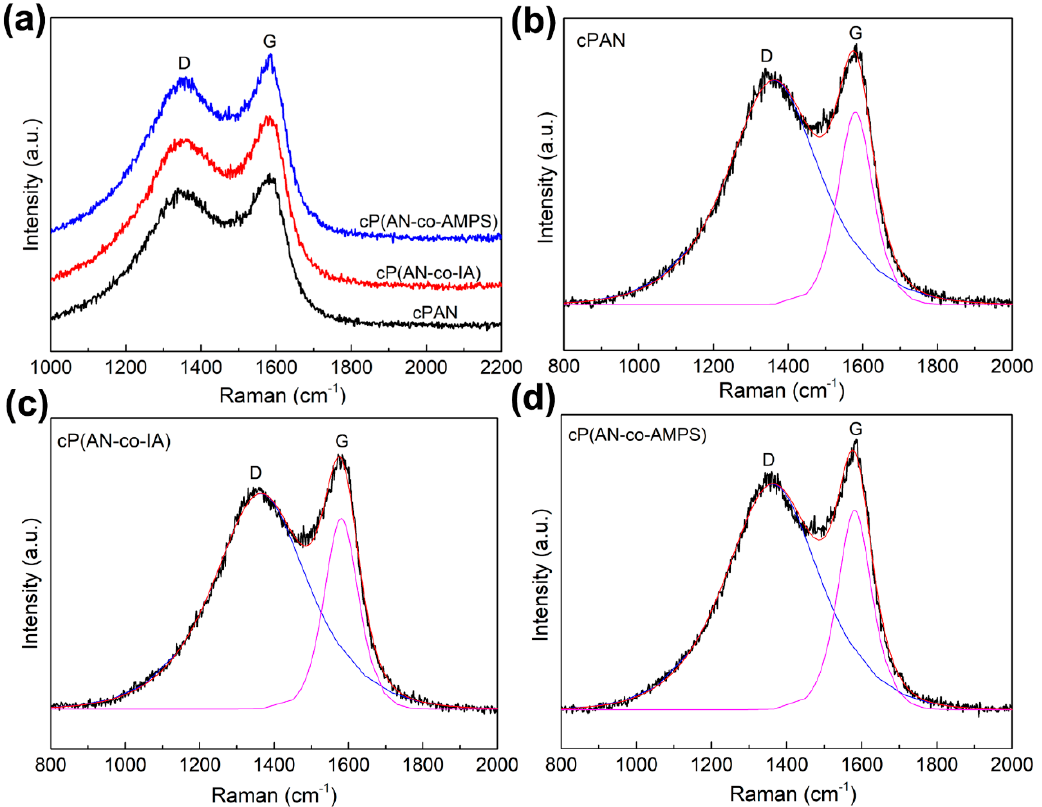
Figure 11. The Raman spectrum ( a ) and the corresponding fitting peaks of ( b ) cPAN, ( c ) cP(AN-co-IA), and ( d ) cP(AN-co-AMPS) nanofibers. (The blue and pink solid lines are the single fitting peaks; the red solid line is the superposition of the two fitting peaks.). Table 3. The detailed peak parameters of cPAN, cP(AN-co-IA), and cP(AN-co-AMPS) nanofibers obtained from the fitting Raman curves.